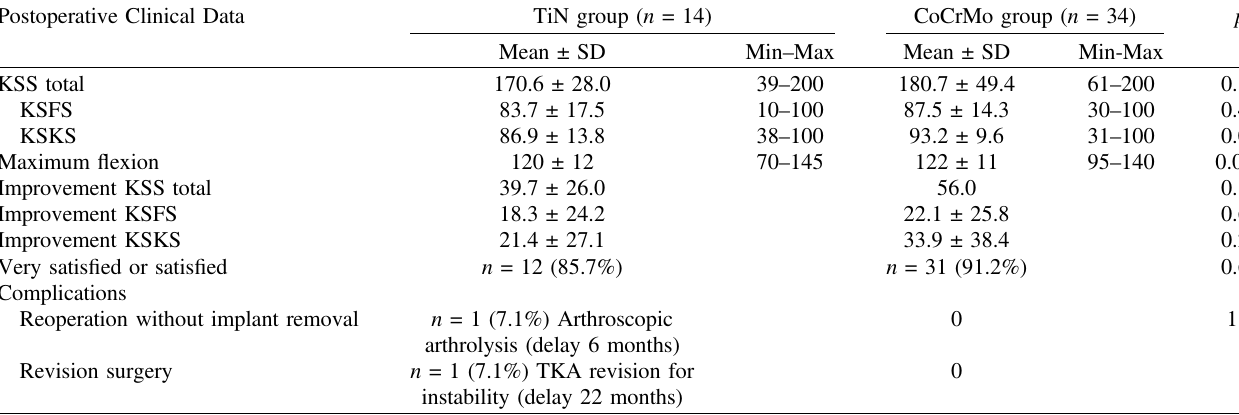
KSS: Knee Society Score; KSFS: Knee Society Function Subscore; Knee Society Knee Subscore Primary